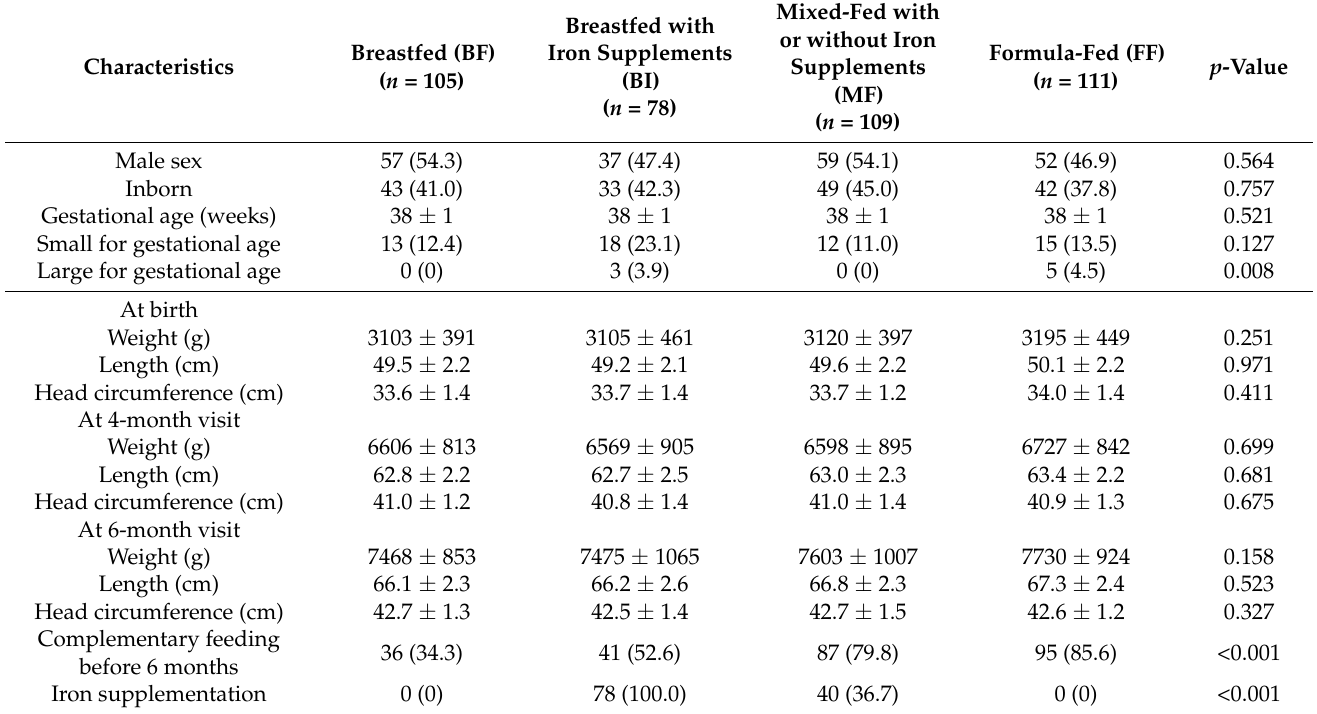
Table 1. Baseline characteristics of infants in the